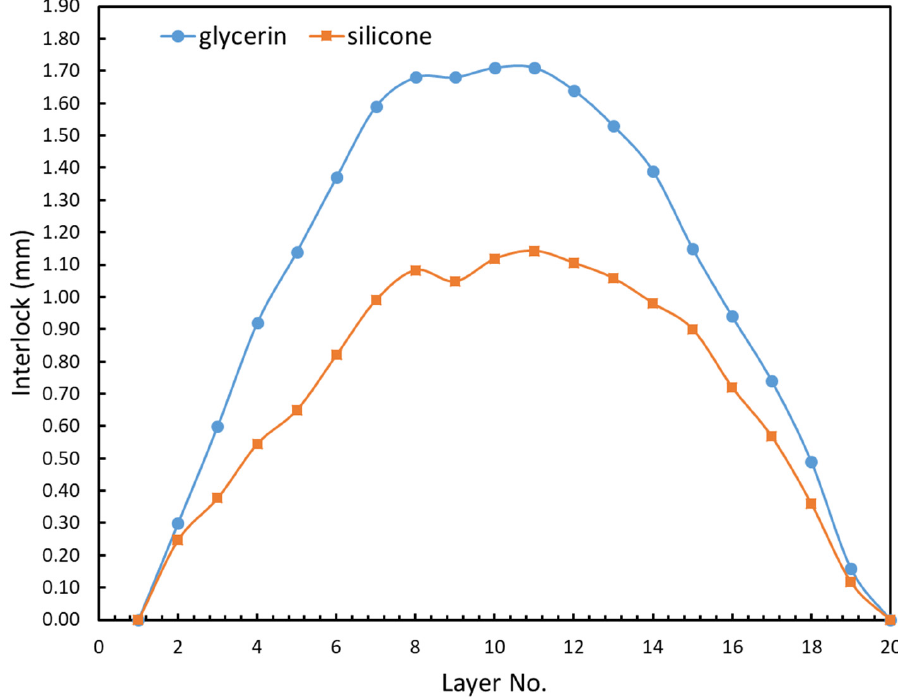
Figure 12. Comparison of interlock between experiments S3 and S4 (12–8 mm, silicone oil and glyc- erin).